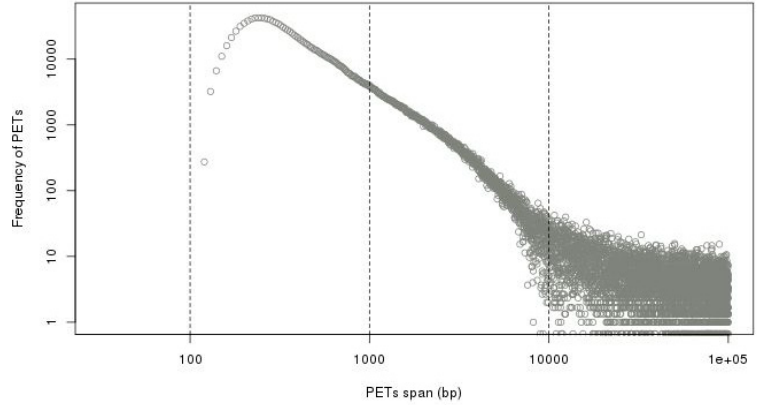
Figure 8. Di ff erence of genomic span distributions from minus-plus ( − /+ ) strand composition and average distribution from other strand compositions in log-log plot. It shows that the self-ligation cutoff is around 8 kb.